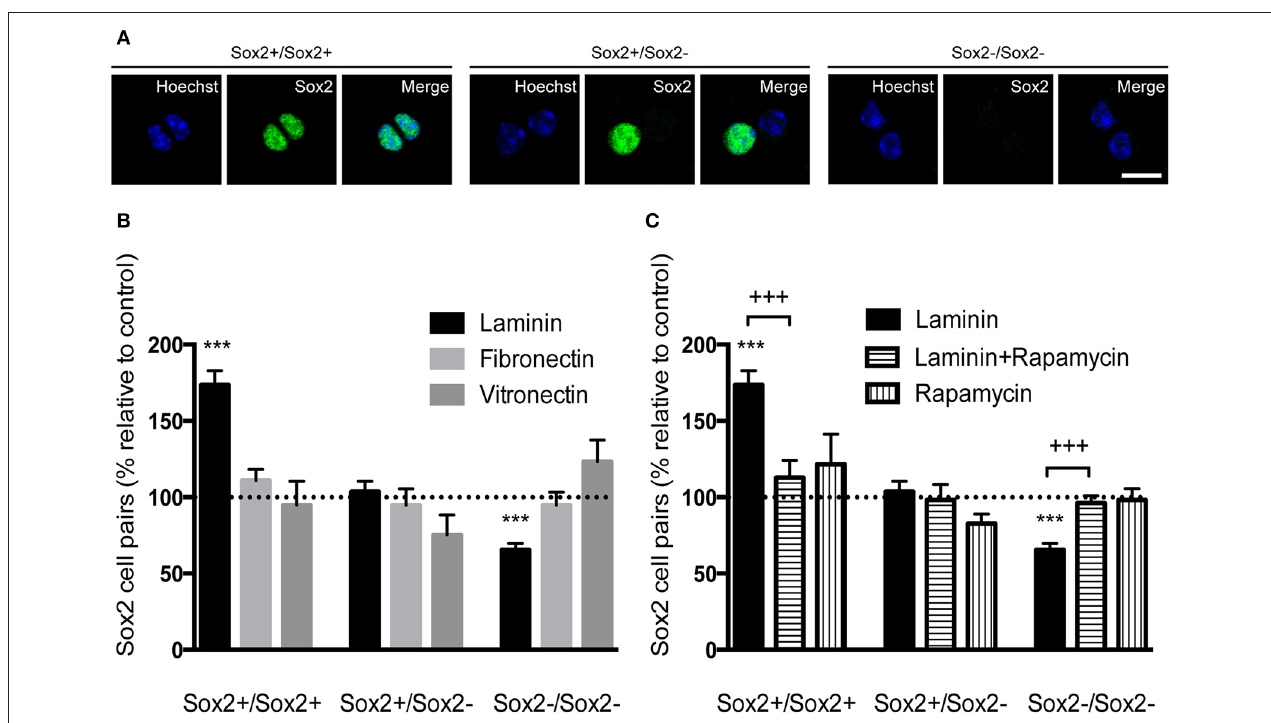
FIGURE 7 | Laminin-1 promotes self-renewing divisions of SVZ precursors via the mTOR pathway. (A) Confocal digital images of cell pairs obtained following (left) the symmetrical division of a SVZ cell into 2 Sox2 + cells, (middle) the asymmetrical division into a Sox2 + and a Sox2 − progenitor and (right) the symmetrical terminal division into 2 Sox2 − progenitors. Scale bars, 10 µ m. (B) Bar graph indicates the percentage of Sox2 + /Sox2 + , Sox2 + /Sox2 − , and Sox2 − /Sox2 − cell pairs in culture when cells were plated on laminin-1, fibronectin or vitronectin, relative to control condition (poly-D-lysine, set at 100%). Note that laminin-1 promotes self-renewal by increasing the number of divisions in Sox2 + /Sox2 + pairs at the expense of terminal divisions. (C) Bar graph shows the percentage of Sox2 + /Sox2 + , Sox2 + /Sox2 − , and Sox2 − /Sox2 − cell pairs relative to control condition (poly-D-lysine, set at 100%) obtained from cells plated on laminin-1, and in the absence or the presence of 20 nM of the mTOR inhibitor rapamycin. Data shows that mTOR is important in the induction of self-renewal by laminin-1. *** P < 0.001, +++ P < 0.001 using unpaired t